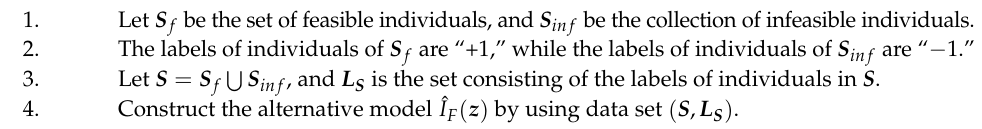
Algorithm 2 SVM for constructing the alternative model ˆ I F ( z )